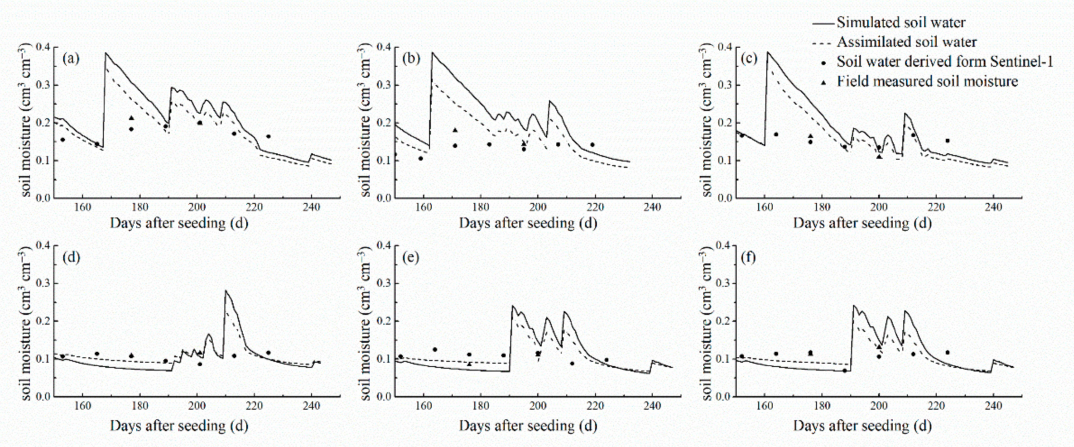
Figure 6. The pattern of simulated soil moisture, assimilated soil moisture, and soil moisture derived from Sentinel-1 from the irrigated areas of winter wheat in ( a ) Nanxindian village of Xiangfen county, ( b ) Zezhang village of Xinjiang county, and ( c ) Su village of Wenxi county and in the rain-fed areas in ( d ) Dongguo village of Xiangfen county, ( e ) Bolin village of Wenxin county, and ( f ) Hutou village of Wenxi county in